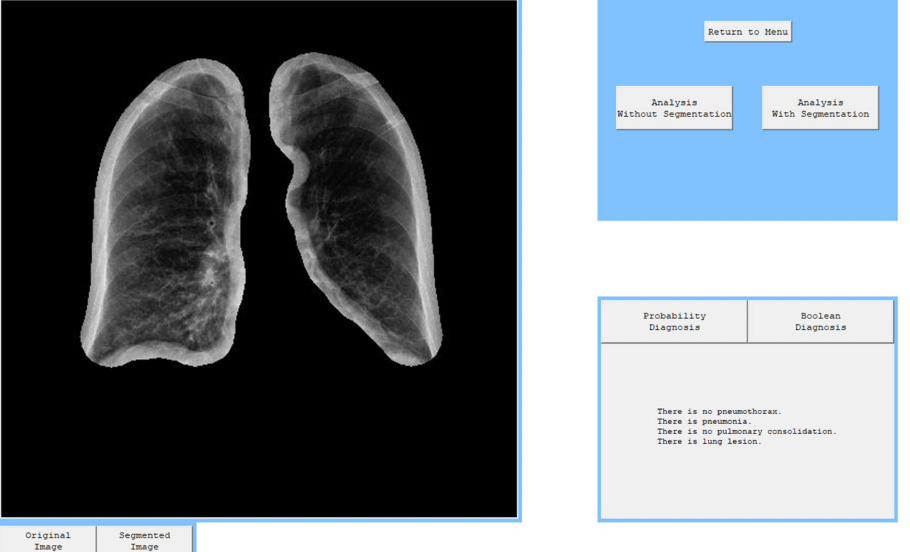
Figure 8. Diagnosis of patient with